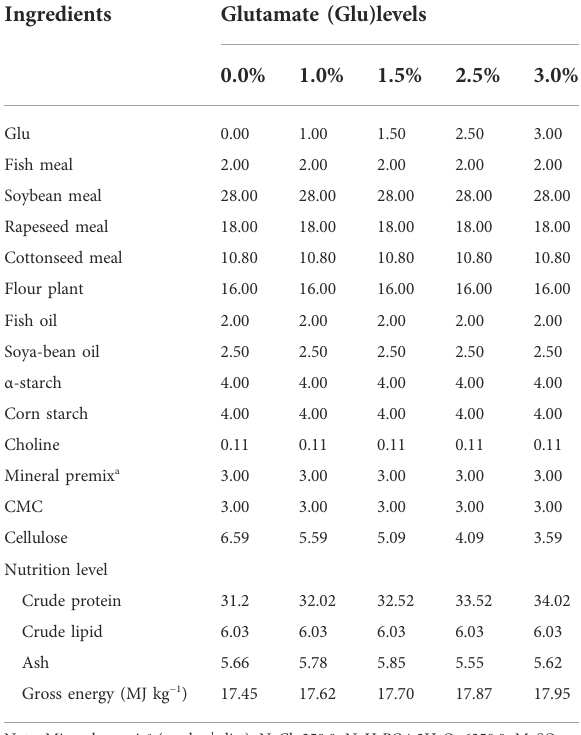
TABLE 2 Formula and nutritional composition of experimental